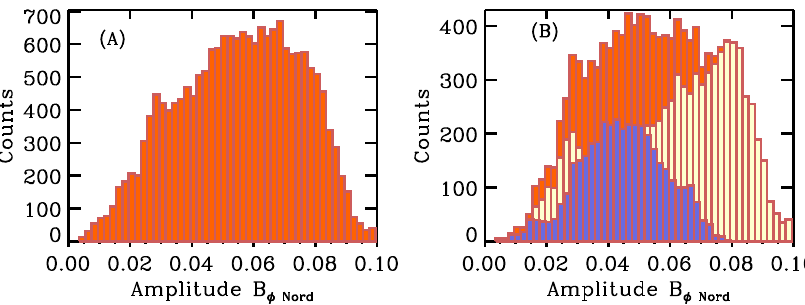
Fig. 11. (A) Amplitude distribution of the toroidal magnetic fi eld maxima extracted from the primary cycle in simulation run 4. Panel (B) separates these amplitude by parity, considering only cycles for which | P | (cid:8) 0.7. The corresponding distribution for symmetric and antisymmetric parity are plotted in yellow and purple, respectively, with their sum in red.